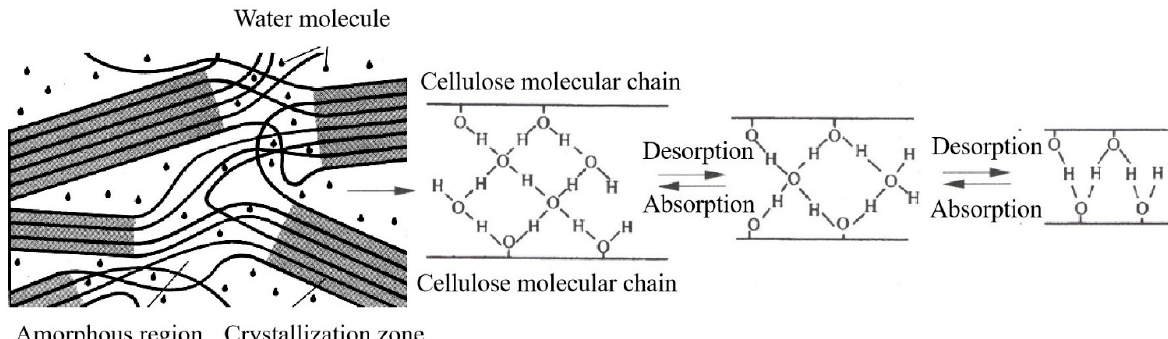
Figure 2. Changes of bound water between microfibril of the non-crystalline area in wood cell walls.